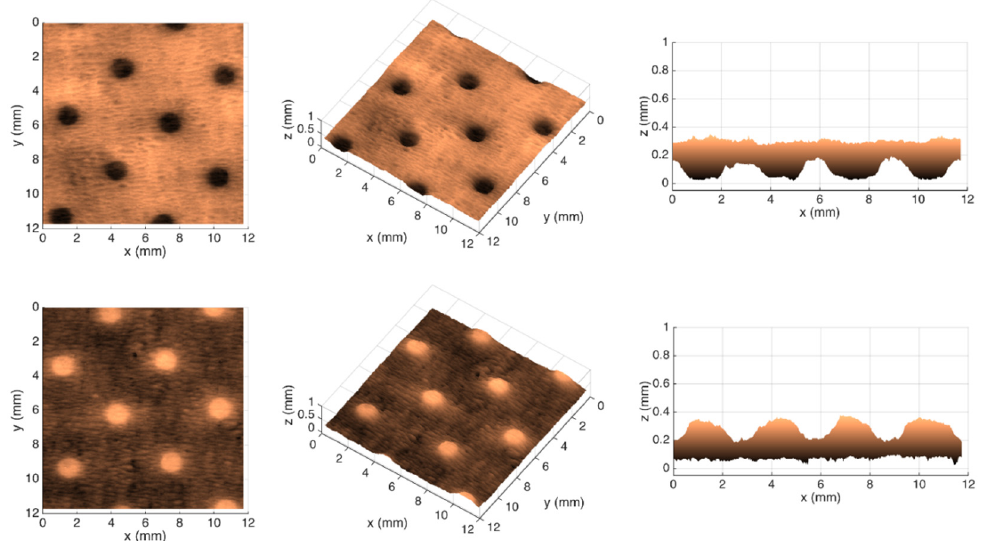
Figure 9. Different views of the 3D maps created for the front and back sides of the tissue-paper sample Bm sd .